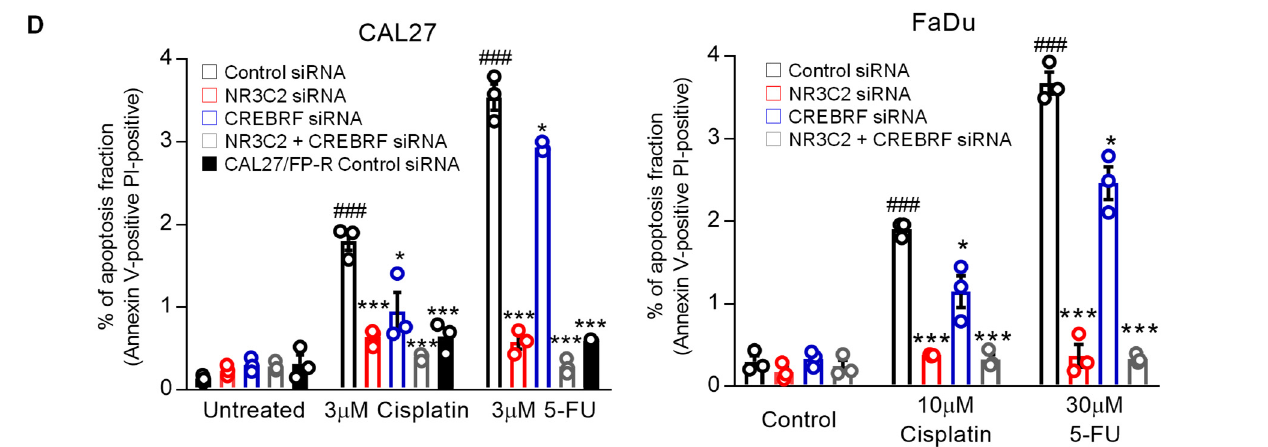
Figure 8. The role of miR124-3p and miR766-3p target genes in HNSCC drug resistance. ( A ) Ex- pression analysis of miR124-3p and miR766-3p direct target genes and downstream target genes by Western blot in HNSCC cell lines (CAL27 and FaDu), with or without transfection with miRNA inhibitors or miRNA mimics. Left: Western blotting showed the expression of miR124-3p target gene (CREBRF) and CREBRF target genes (ATG5 and CREB3). Right: Western blotting showed the expression of miR766-3p target gene (NR3C2) and NR3C2 target genes ( β -catenin and c-Myc). Quantitative data (relative expression levels after β -actin-corrected) from three independent exper- iments are disclosed below each protein band. Data represent the mean ± SD (n = 3). ( B ) Target gene analysis in sensitive (CAL27) vs. resistant (CAL27/FP-R) HNSCC cell lines. Quantitative data (relative expression levels after β -actin-corrected) is shown below each protein band. ( C ) The effect of NR3C2 and/or CREBRF knockdown on drug-induced cytotoxicity in CAL27 and FaDu. Cells were transfected by 10 nM siRNA (single or combined) for 24 h followed by 72 h exposure to the indicated drug. Cytotoxicity was determined by MTT assay. IC 50 values are listed in Table S7. ( D ) Measurement of apoptosis in CAL27 or FaDu cells in response to cisplatin or 5-FU ± 24 h prior transfection with 10 nM siRNA. After 24 h of drug treatments, cells were labeled with anti-annexin V-FITC antibody and PI and then analyzed with flow cytometry. A two-way ANOVA with Bonferroni’s correction for multiple comparisons was used to analyze group comparisons, and data are presented as means ± SD (n = 3). * p < 0.05, *** p < 0.001 (vs. control siRNA), and ### p < 0.001 (vs.